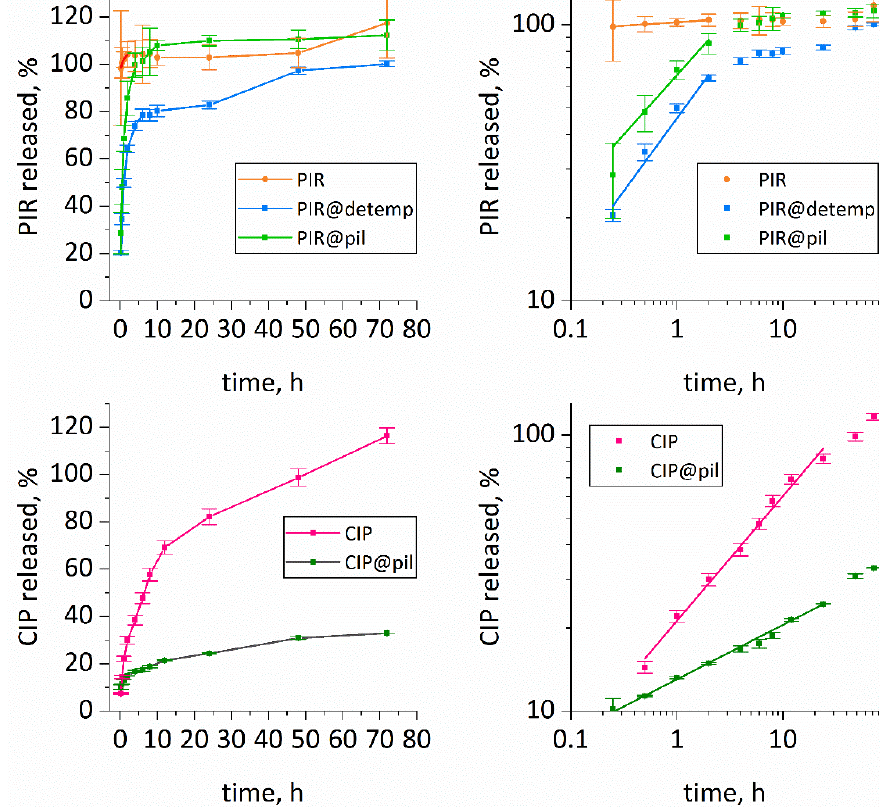
Figure 4. The piracetam (PIR) and ciprofloxacin (CIP) release profiles from detemplated (detemp) and pillared (pil) ZSM-55. The graphs show linear (left panes) and double-logarithmic representation (right panes) with fitting to Korsmeyer-Peppas law. Alternative representations of the data are available in supplementary material (Figure S1).